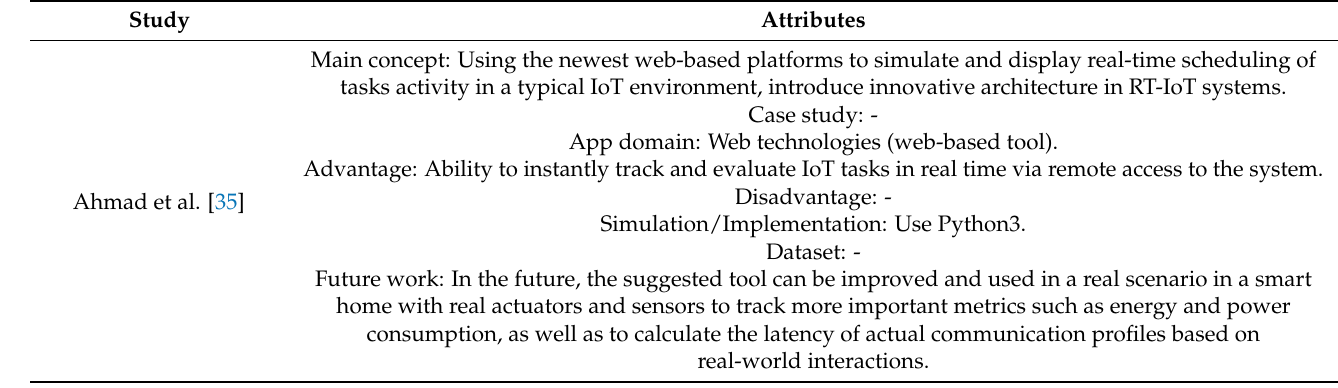
Table 10. Categorizing the state-of-the-art in smart farming applications.